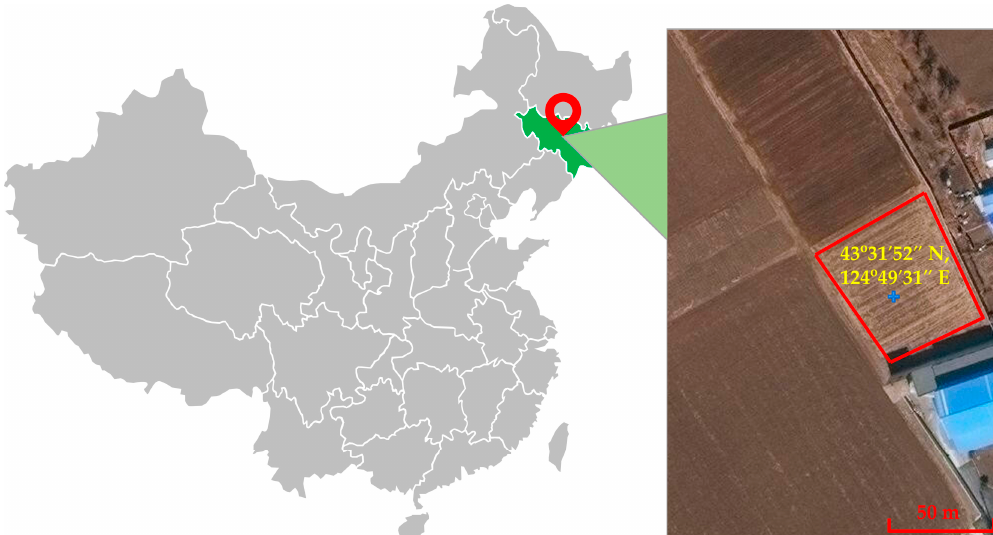
Figure 1. The location of field experiment. The area framed by the red line in the image was the experiment site. The numbers and letters in yellow color were the longitude and latitude of the experiment site.